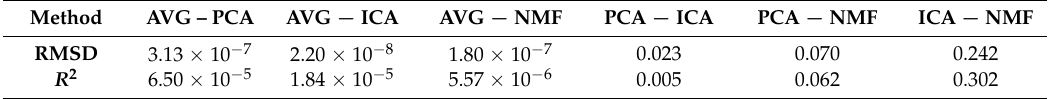
Table 3. The p values of the paired tests in ANOVA.